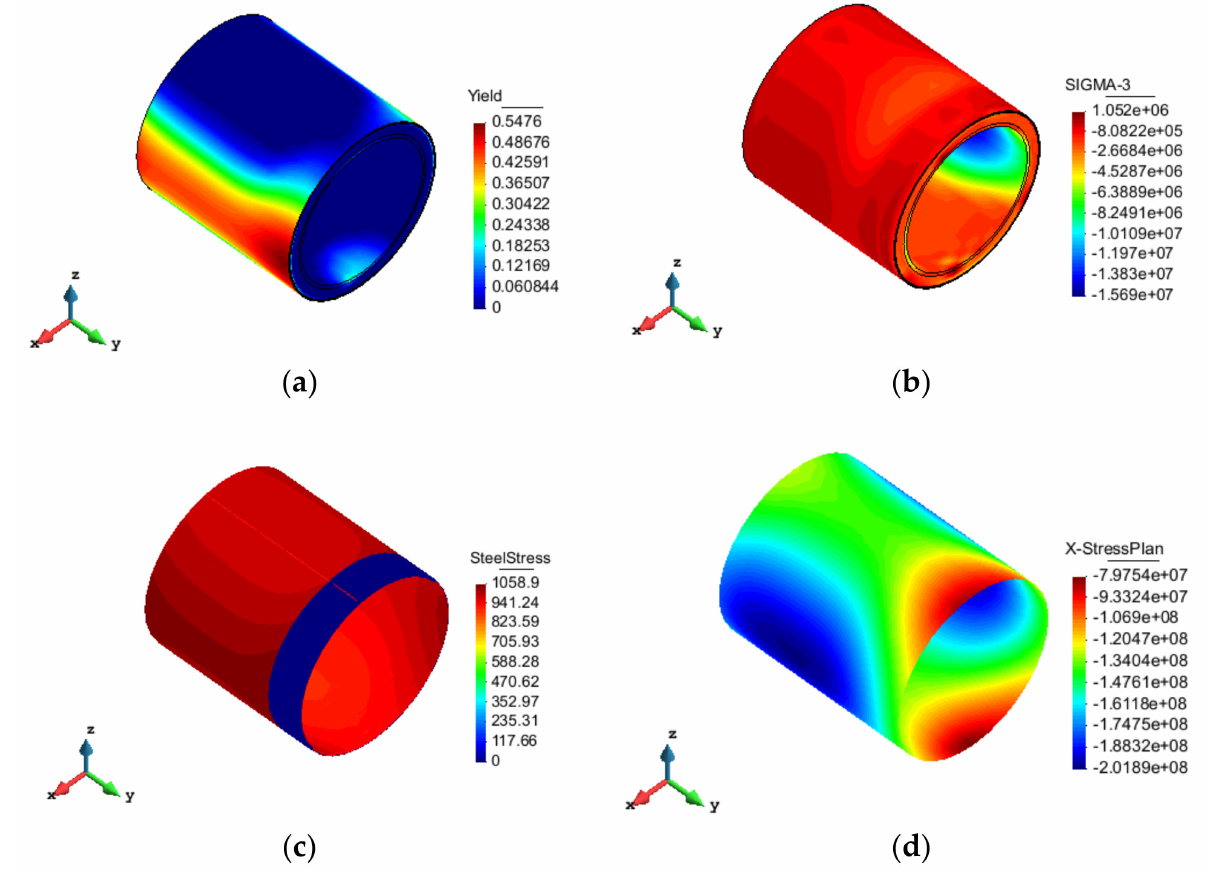
Figure 10. Nephogram of case 2: ( a ) damage, ( b ) 3rd principal stress, ( c ) wire stress, ( d ) cylinder